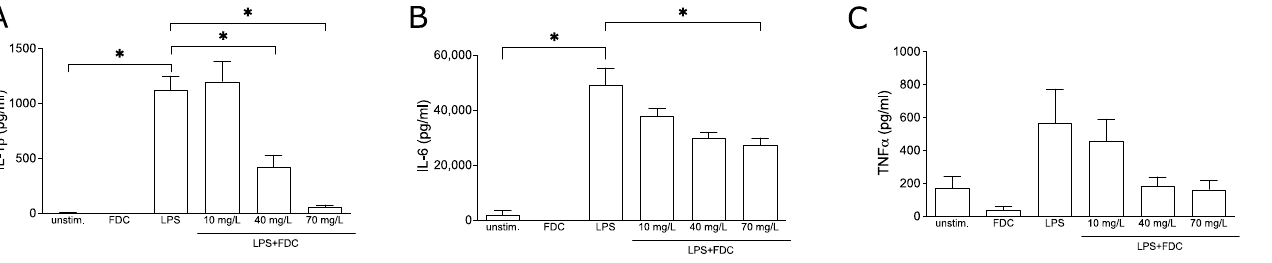
Figure 1. Cefiderocol dampens LPS-stimulated production of pro-inflammatory cytokines. PBMCs were stimulated with 100 ng/mL LPS with or without cefiderocol (FDC 10 mg/L, 40 mg/L, 70 mg/L) for 3 days. Unstimulated PBMCs were incubated with 70 mg/L FDC as negative controls. Supernatant was used for ELISA analysis of IL-1 β ( A ), IL-6 ( B ) and TNF- α ( C ). Shown are mean and standard deviation of three biological replicates ( n = 3). Statistical significance was calculated using a one-sided Mann–Whitney U test ( p < 0.05 = *). Abbreviations: FDC = cefiderocol, LPS = lipopolysaccharide, TNF- α = tumor necrosis factor- α .